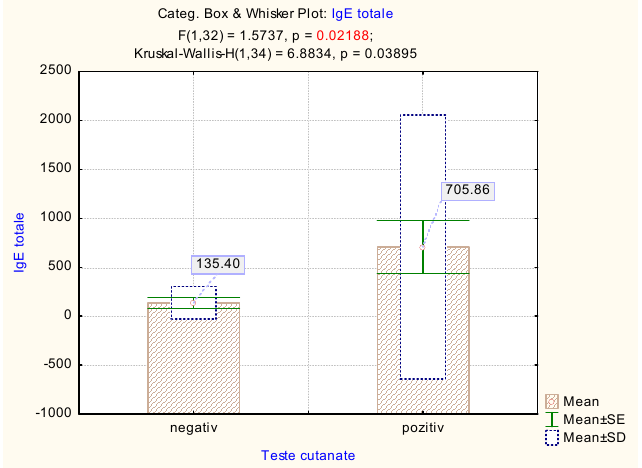
Figure 8. The mean value of total IgE vs. skin prick test results. Table 8. The test for a comparison of total IgE values vs. skin prick test results.